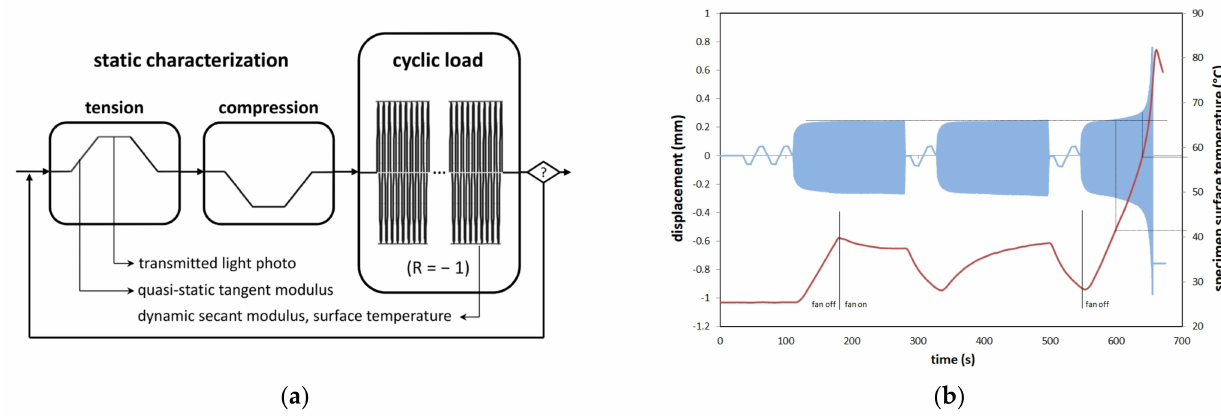
Figure 3. ( a ) Interrupted fatigue test sequence containing static characterisation steps for transmitted light monitoring and tangent modulus determination, measurement of surface temperature and dynamic secant modulus during the fatigue loading blocks; ( b ) Exemplary plot of specimen surface temperature development during cyclic loading, effect of air-cooling and temperature-induced thermo-mechanical failure without